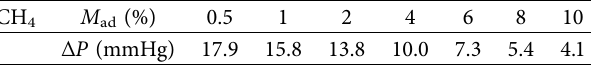
Figure 8: Te relationship between desorption velocity and time of methane in coal. (a) Time range 0s–10 s; (b) time range 45s–60s. Table 1: Index ∆ P measurement results.